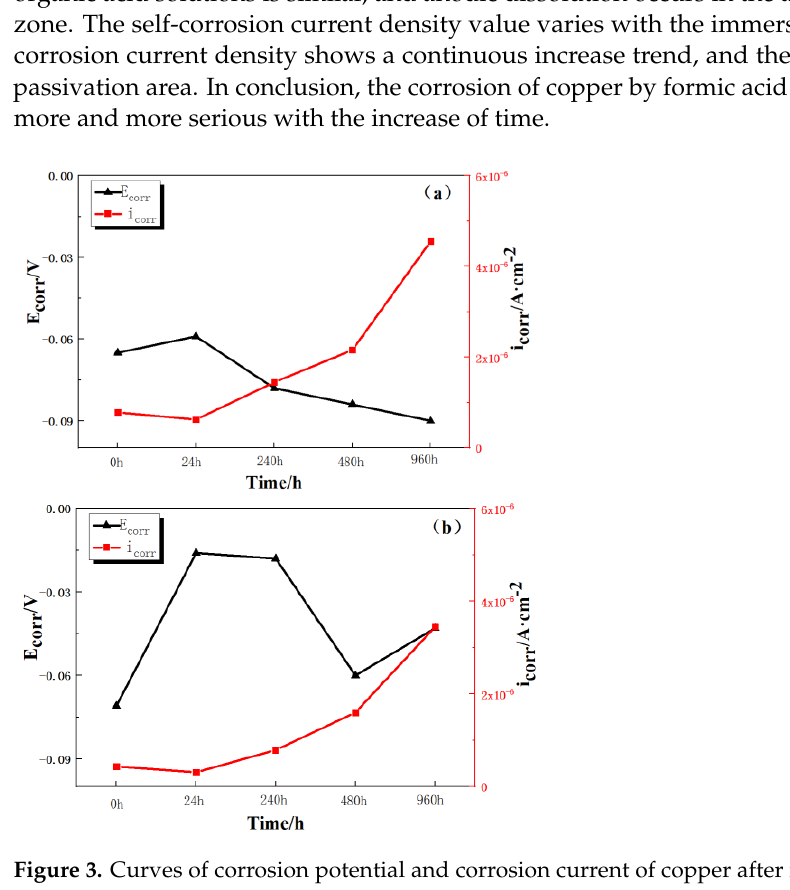
Figure 5. Results of electrochemical impedance spectroscopy of copper immersed in acetic acid so- lution for different time. Figure 6. Impedance spectrum equivalent circuit diagram of copper in organic acid. As shown in the electrochemical impedance spectra shown in Figures 4 and 5, the Nyquist plots of TP2 copper in formic acid and acetic acid solutions have two capacitive reactance arcs, corresponding to two capacitive reactance peaks in the Bode plot. The ca- pacitive arc radius reflects the film-forming properties of the metal passivation film. The larger the capacitive arc radius, the better the corrosion resistance and the higher the pas- sivation film impedance [28]. As shown in the Nyquist diagram, the radius of the capaci- tive reactance arc of TP2 copper increases first and then decreases with the increase of immersion time, showing a large capacitive reactance arc in the high frequency region, and the capacitive reactance of the sample in formic acid the arcs are smaller than the capacitive arc in acetic acid solution. The radius of the capacitive reactance arc after im- mersion for 24 h is the largest, which may be because the red copper in the organic acid solution will oxidize in pure water at first to form a Cu 2 O passivation film. With the in- creasing immersion time, both groups of capacitive reactance arc radius are decreasing. Tables 2 and 3 are the equivalent circuit data, where R s is the solution resistance, R f is the passivation film resistance, R ct is the charge transfer resistance, Cdl is the double layer capacitance, and Cf is constant phase angle elements of electric double layer capac- itors. At the initial stage of immersion, the R ct value of copper in acetic acid was 4.45 × 10 4 Ω, which was significantly higher than that in formic acid, which was 2.31 × 10 4 Ω. At the